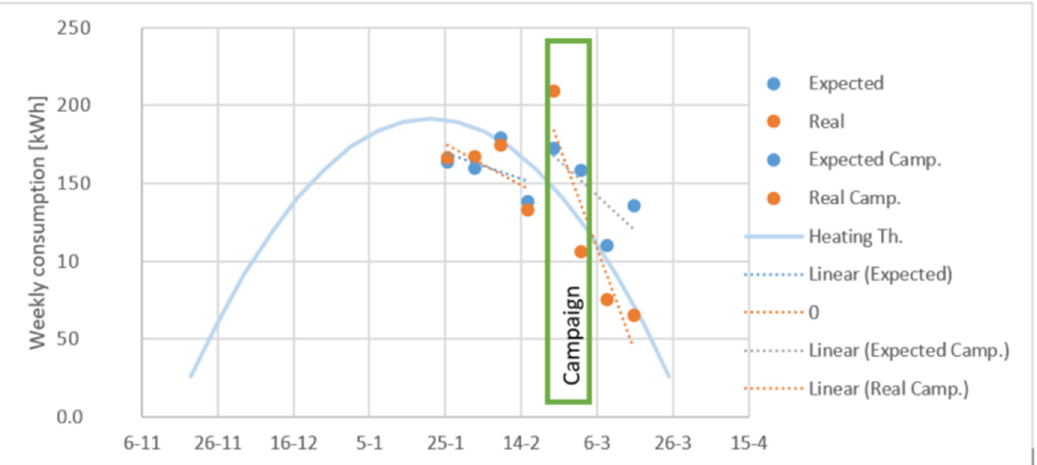
Figure 2. Data of weekly energy use for heating before, during and after the campaign. The points are drawn over a curve representing theoretical energy use for heating due to weather. Table 2. Energy savings for heating in campaign.